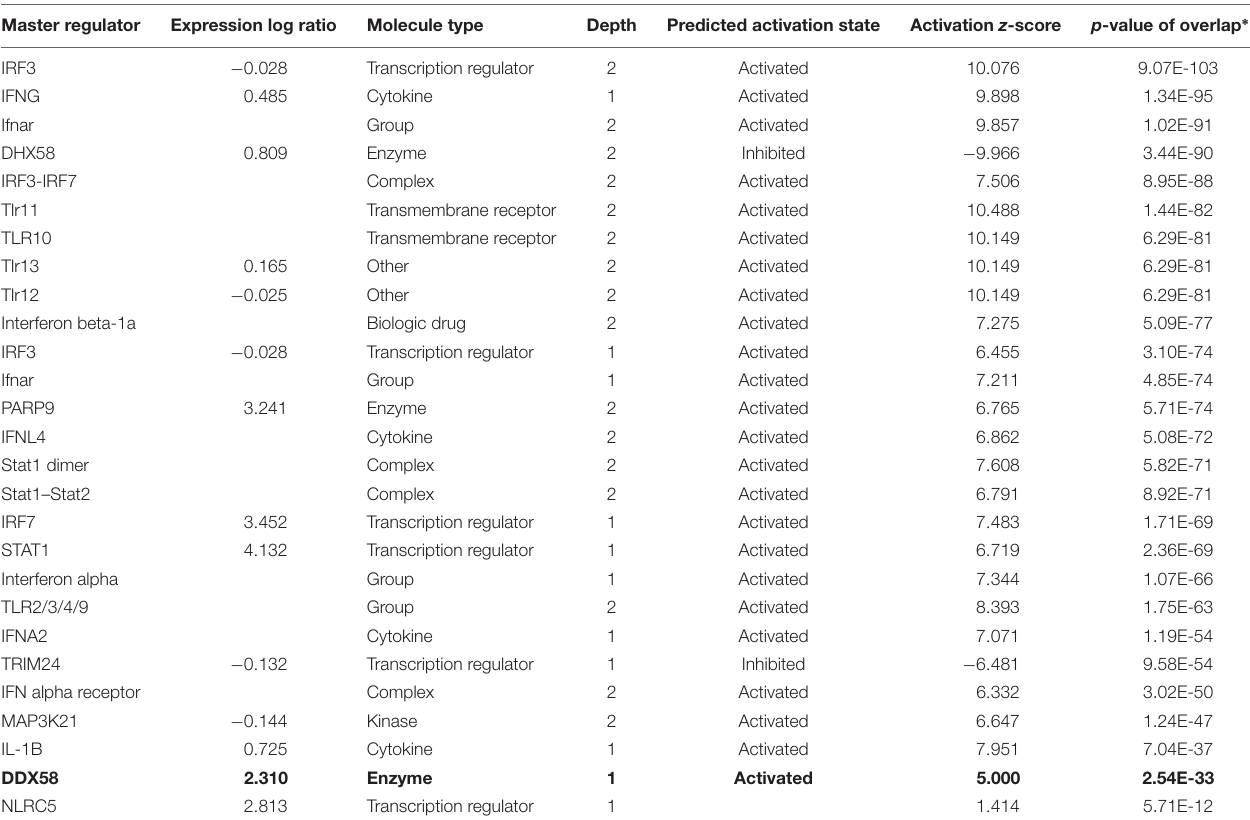
TABLE 2 | Regulators of innate immunity and cell death identified by the CNA tool of IPA. Master